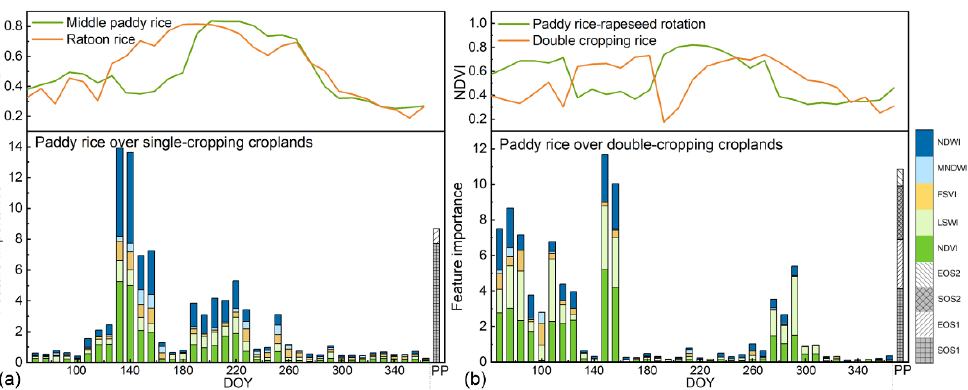
Figure 8. The feature importance of spectral – temporal information and phenological phase (PP) ( a ) for identifying middle paddy rice and ratoon rice in the single-cropping paddy rice group and ( b ) for identifying paddy-rice – rapeseed rotation and double-cropping paddy rice in the double-cropping paddy rice group. The top panel of each figure shows the temporal trajectory of NDVI for each PRCP.